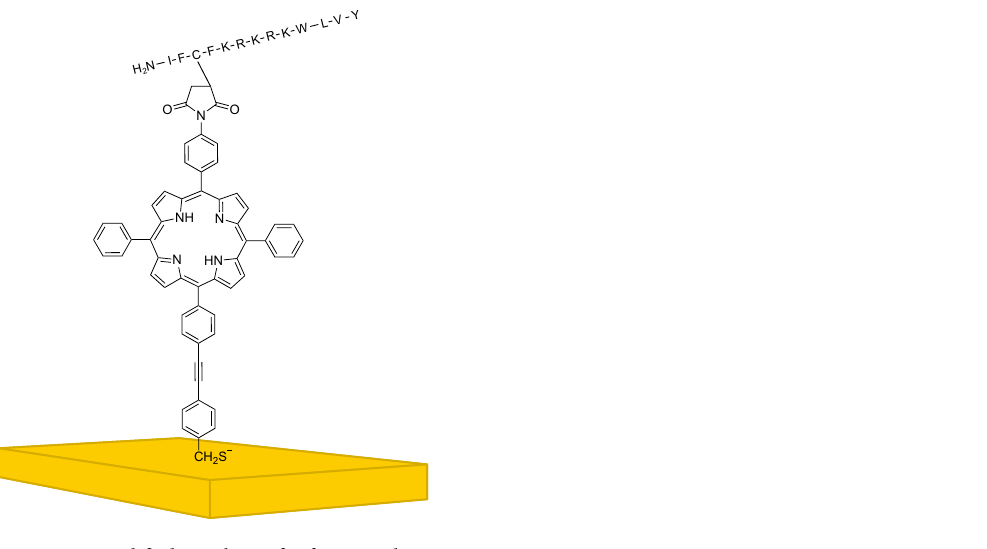
Figure 1. Modified porphyrin for functionalization